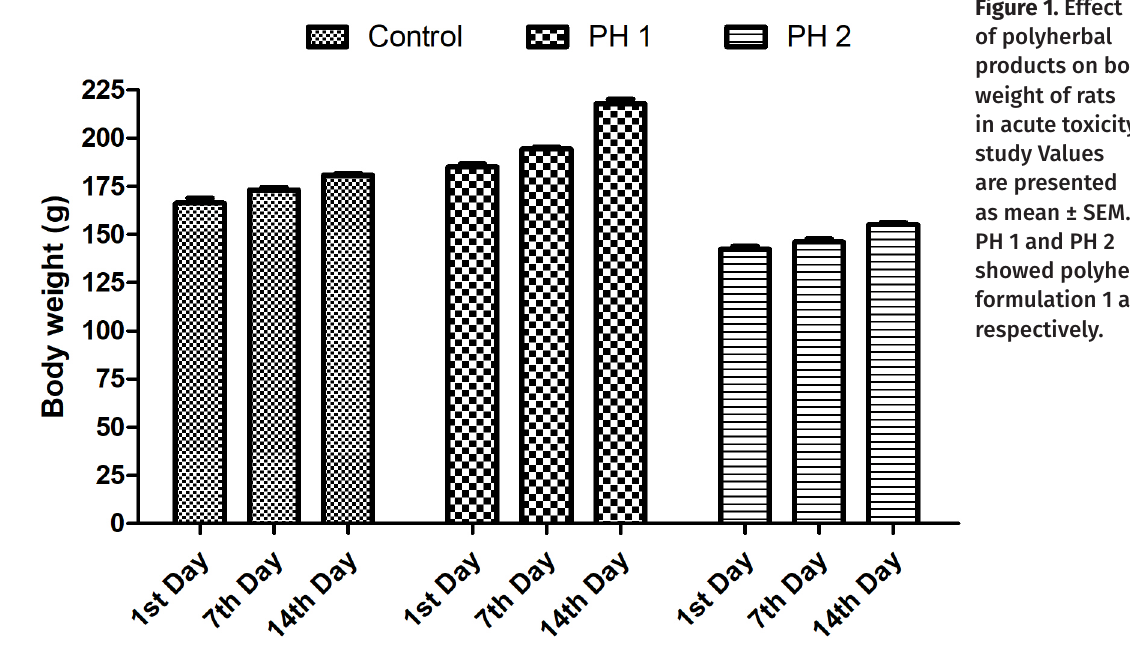
of polyherbal products on body weight of rats in acute toxicity study Values are presented as mean ± SEM. PH 1 and PH 2 showed polyherbal formulation 1 and 2